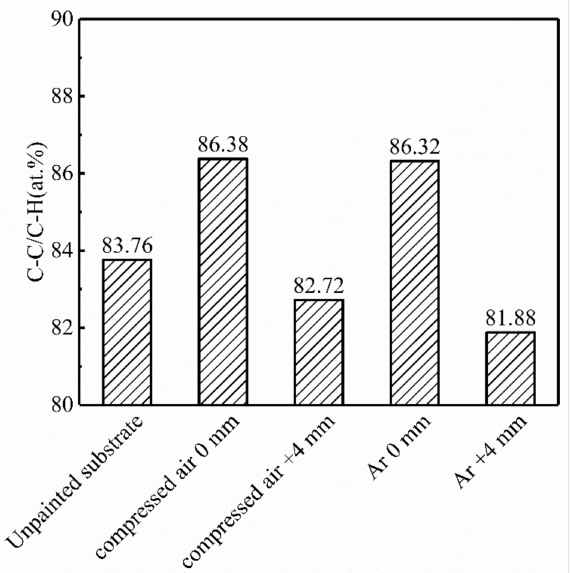
Figure 9. Relative amount of C-C/C-H functional groups (at.%) on samples measured by